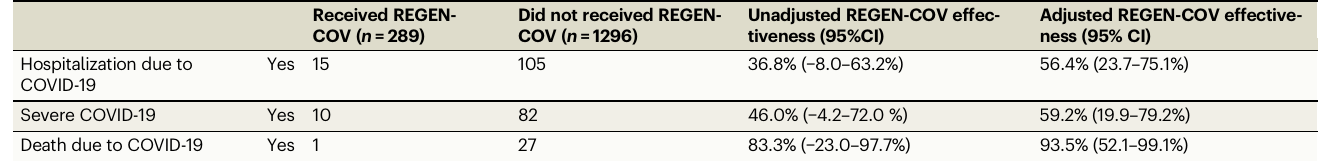
Table 2 | Outcomes associated with REGEN-COV treatment